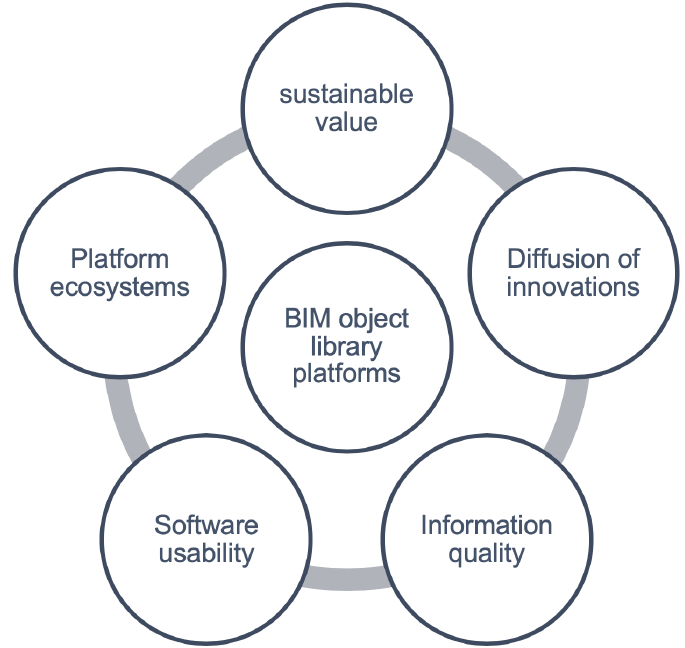
Fig. 1. The conceptual framework for studying the role of BIM object library platforms in the diffusion of sustainable